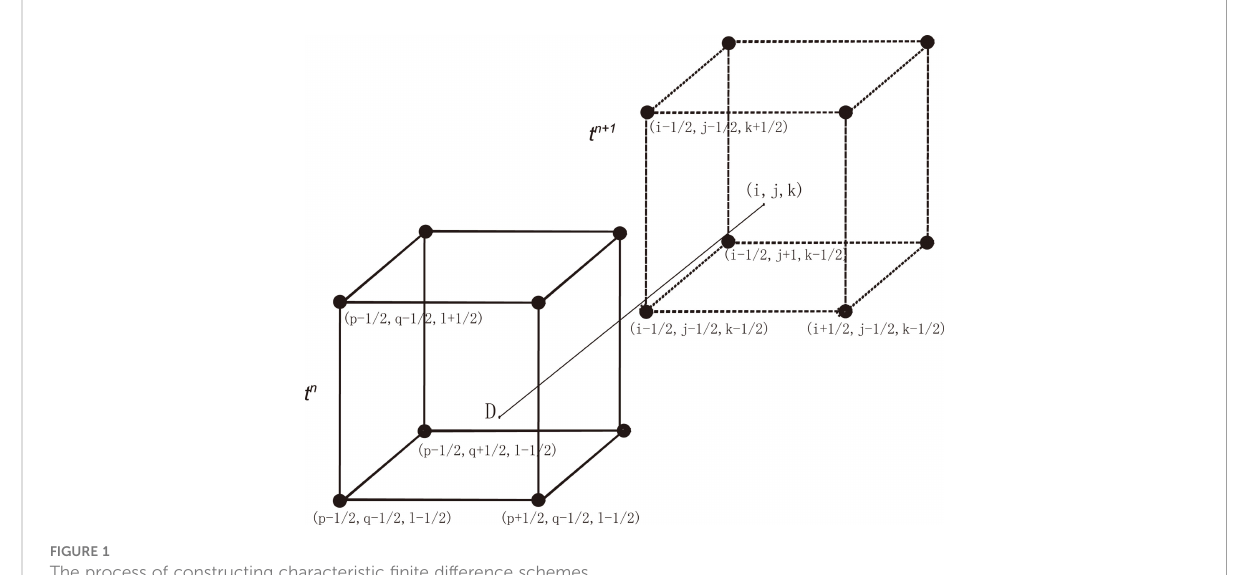
FIGURE 1 The process of constructing characteristic fi nite difference